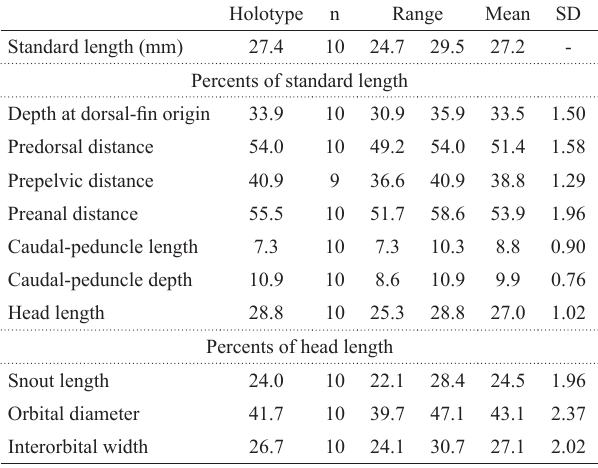
Tab. 1. Morphometric data of holotype and paratypes of Phenacogaster julliae (n = number of specimens, holotype included). SD = standard deviation.